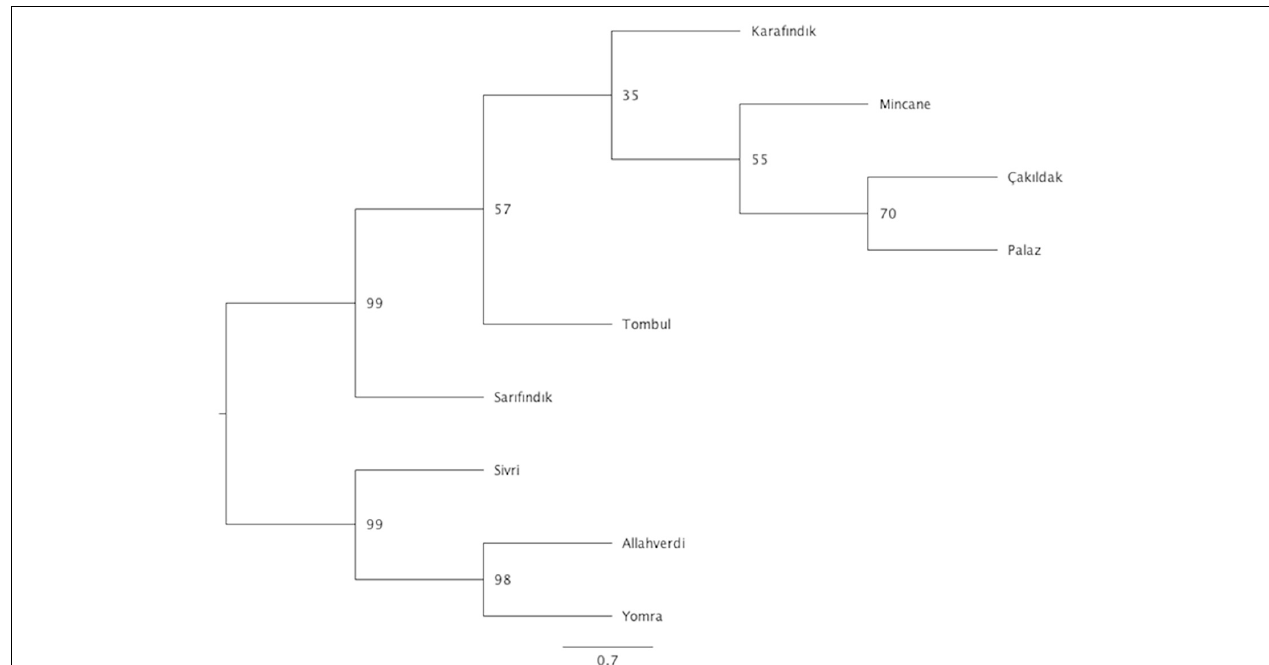
FIGURE 4 | Phylogenetic tree of hazelnut varieties. Bootstrapping values are indicated on the nodes, while scale bar indicates genetic distance. No. of individuals for ‘Allahverdi’, 2; ‘Çakıldak’, 3; ‘Karafındık’, 2; ‘Mincane’, 2; ‘Palaz’, 5; ‘Sarıfındık’, 5; ‘Sivri’, 4; ‘Tombul’, 8; and ‘Yomra’,